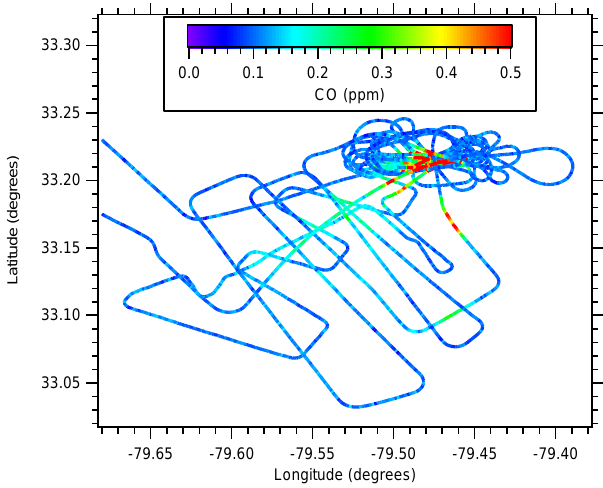
Figure 1. Example of a typical flight path. This flight path is from RF08 and is colored by CO to indicate the location of the burn and where the smoke plume was intercepted